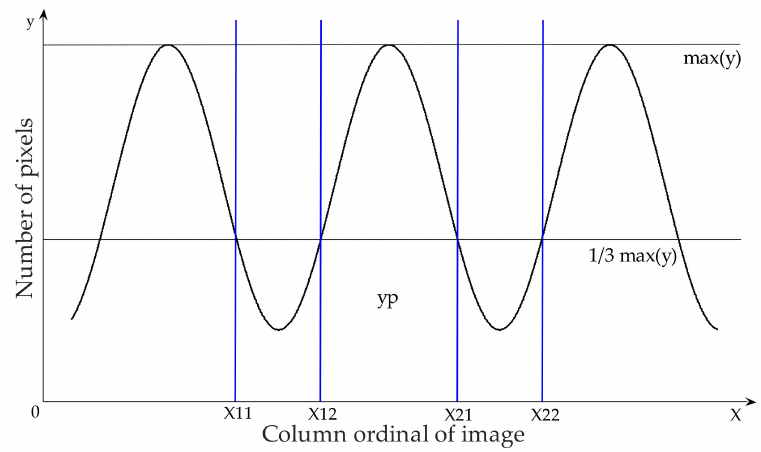
Figure 3. Schematic diagram of pixel lateral